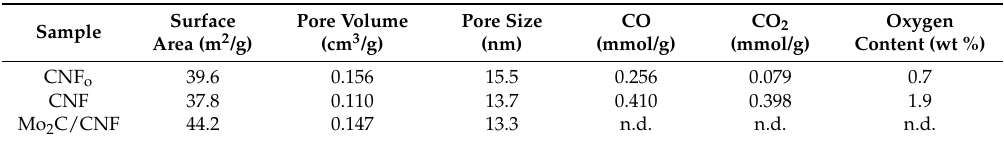
Table 1. Results of N 2 -physisorption and Temperature Programmed Desorption (TPD) of the bare commercial nanofibers (CNFs) supports (CNF o = as received carbon nanofibers; CNF—pretreated carbon